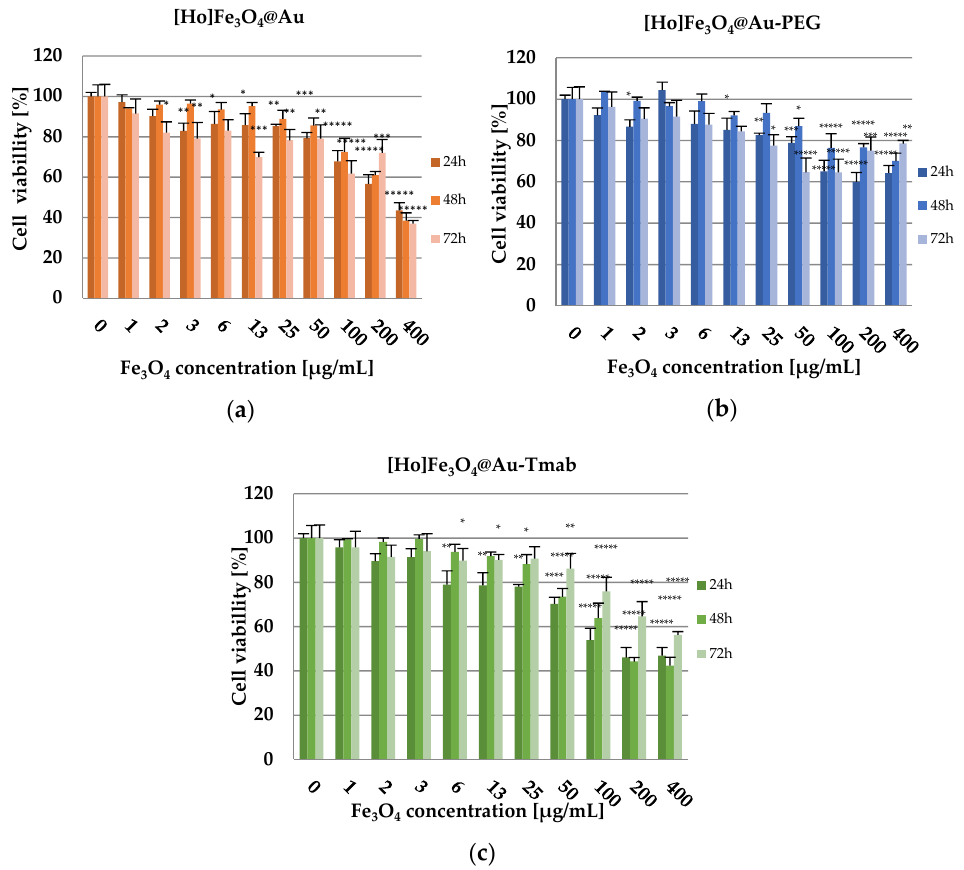
Figure 9. Cell viability after treatment with different concentrations of: ( a ) [Ho]Fe 3 O 4 @Au, ( b ) [Ho]Fe 3 O 4 @Au-PEG, and ( c ) [Ho]Fe 3 O 4 @Au-Tmab. SKOV-3 were incubated for 24, 48, and 72 h, after which their viability was determined by MTS assay. The results are expressed as a percentage of control cells. Data are expressed as the mean ± SD ( n = 3). Statistical significance was considered if p < 0.05 (*), p < 0.01 (**), p < 0.001(***), p < 0.0001 (****), p < 0.00001(*****).